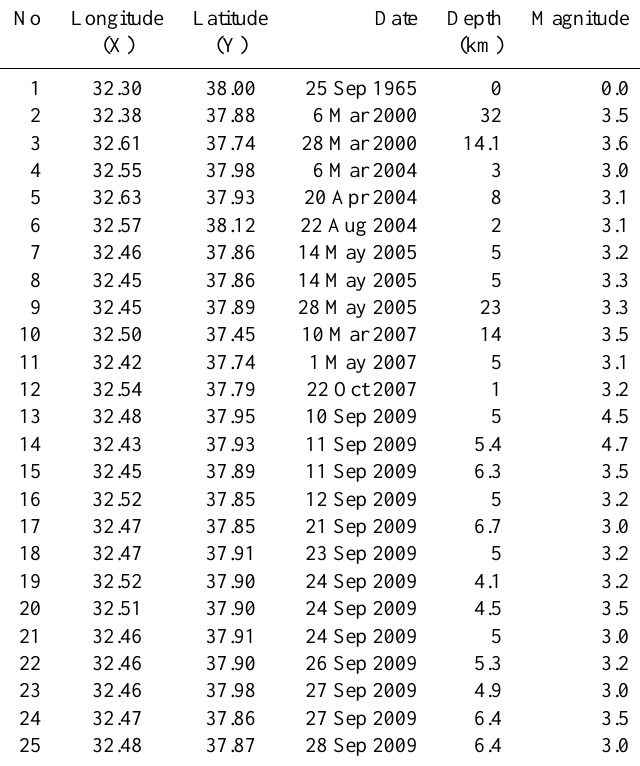
Table 1. List of earthquakes occurred around Konya. Data obtained from Bo˘gazic¸i University Kandilli Observatory and Earthquake Research Institute (Koeri: